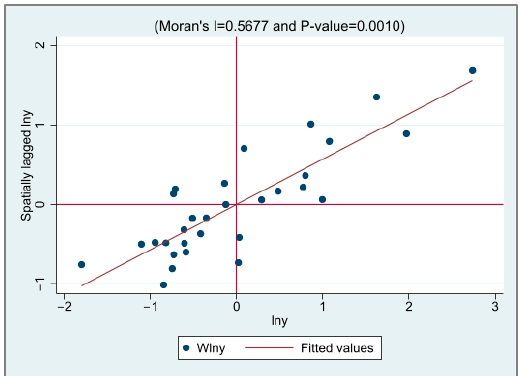
Figure 1. The scatter plot of the Moran index of EG in 2000.